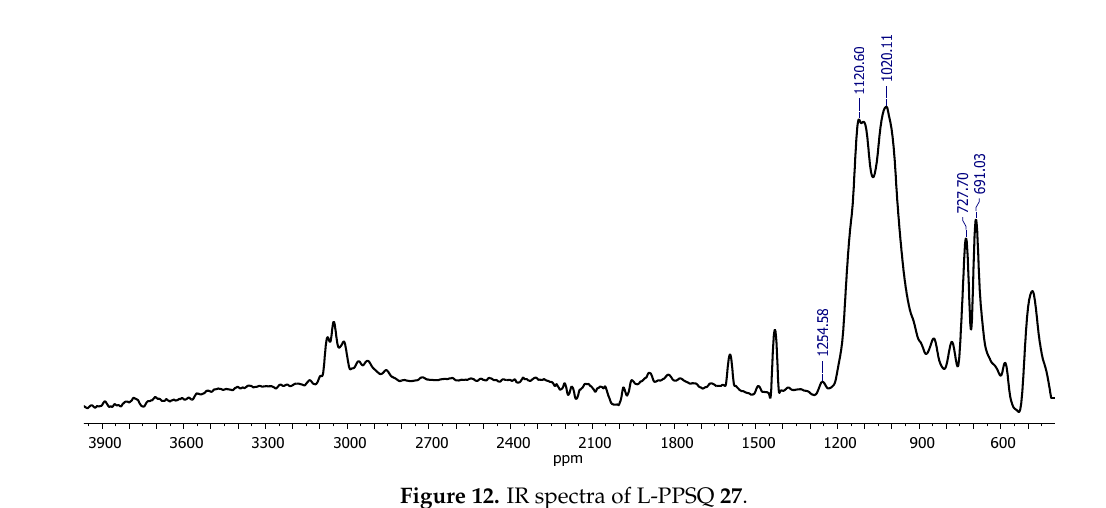
Figure 12. IR spectra of L-PPSQ 27 .